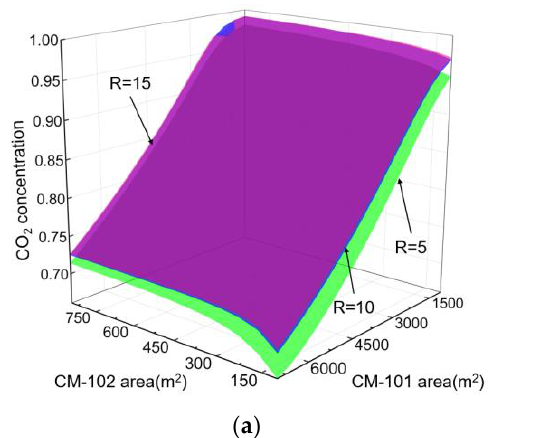
( b ) Figure 5. Effect of CO 2 concentration of CM-101 residue on membrane area under different permeate pressures. ( a ) Diagram under 200 and 300 kPa; ( b ) diagram under 600 kPa. 5.2.2. Effect of CM-101 and CM-102 Area on CO 2 Product The area of the membrane determines the total investment for the membrane separator and product quality, so we studied the effect of CM-101 and CM-102 area on CO 2 concentration and removal rate in the NMGH process to determine the appropriate carbon membrane area, the result of which is shown in Figure 6. According to this graph, we can see that the purity of the CO 2 product increased with the increasing CM-101 area when the CM-102 area was fixed, while the removal rate was basically unchanged. When fixing the area of CM-101 and changing the area of CM-102, the